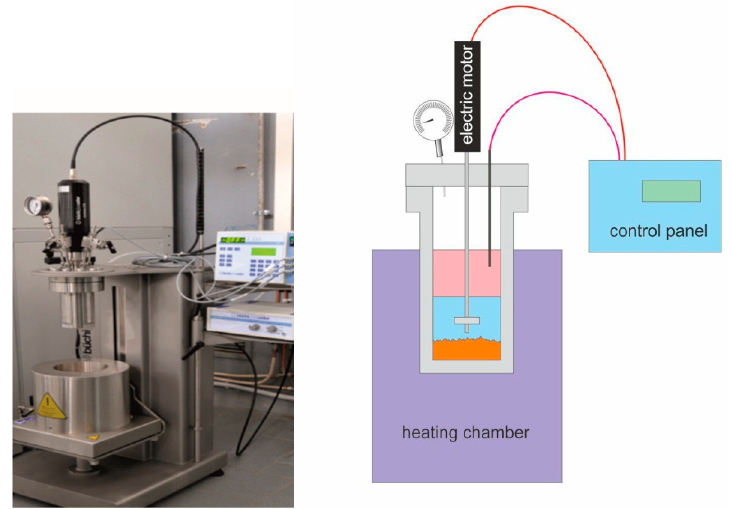
Figure 2. Picture and sketch of the batch reactor used to perform the experiments (PARR, mod. Autoclave Buchi Limbo-li ® ).